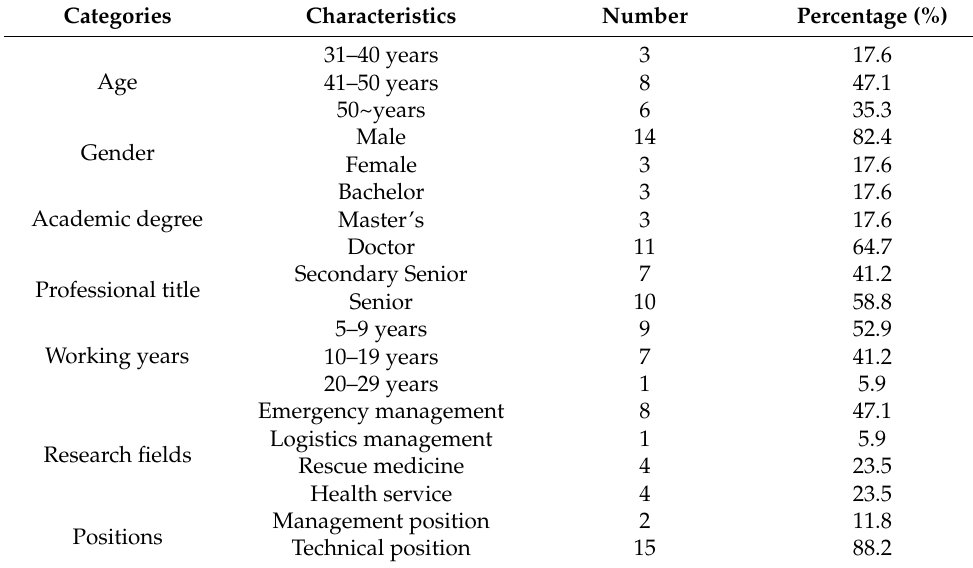
Table 1. Demographics of the panelists ( n =